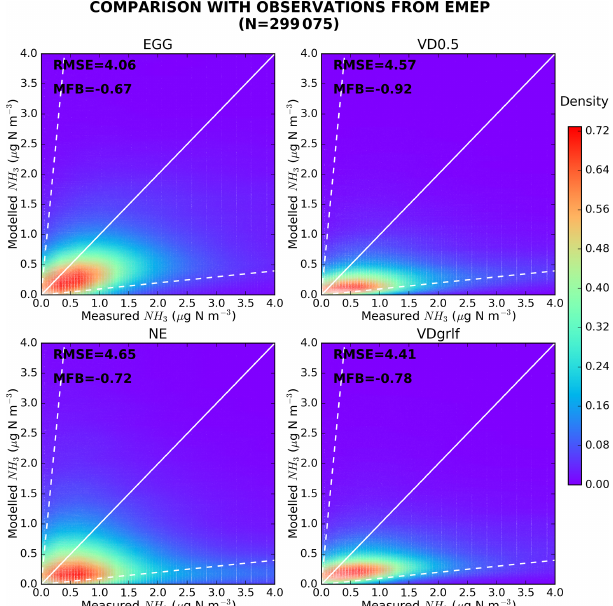
Figure 5. Validation of modelled concentrations of ammonia for different emissions datasets (EGG, VD0.5, NE and VDgrlf) against ground-based measurements from EMEP for the 10-year (2008– 2017) study period. Scatterplots of modelled against measured con- centrations for the aforementioned emission inventories were plot- ted with the Kernel density estimation, which is a way to estimate the probability density function (PDF) of a random variable in a non-parametric way.